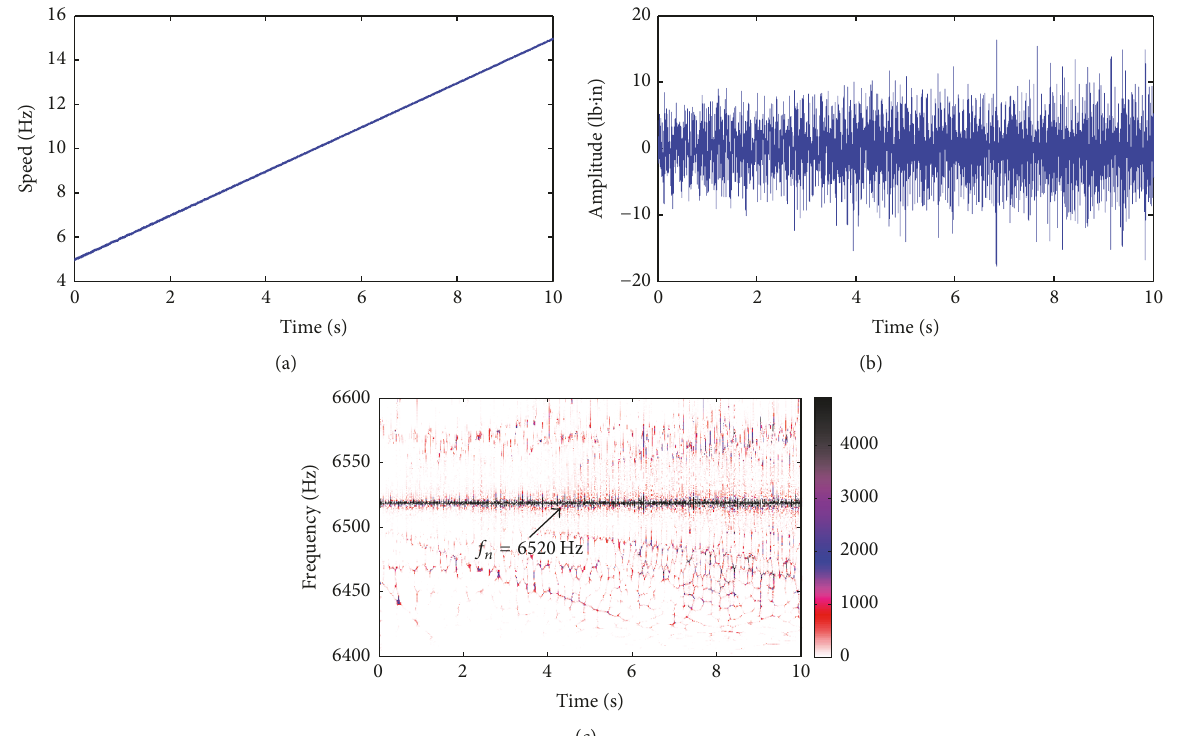
Figure 12: Resonance frequency identification: (a) drive motor speed, (b) detrended torsional vibration signal, and (c) reassigned Morlet